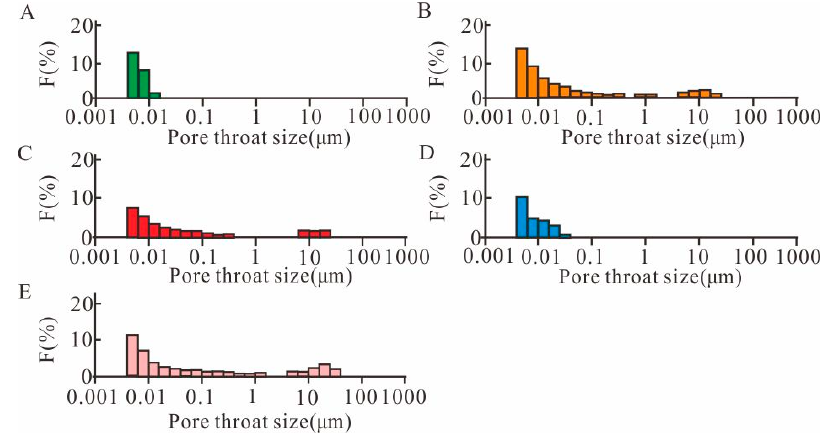
Figure 7. The distribution characteristics of pore throat size in five types of lithofacies. ( A ) for sample FY-5 of marl; ( B ) for sample FY-12 of silty shale; ( C ) for sample FY-9 of argillaceous shale; ( D ) for sample FY-16 of muddy siltstone; ( E ) for sample FY-9 of calcareous shale. F: Frequency.